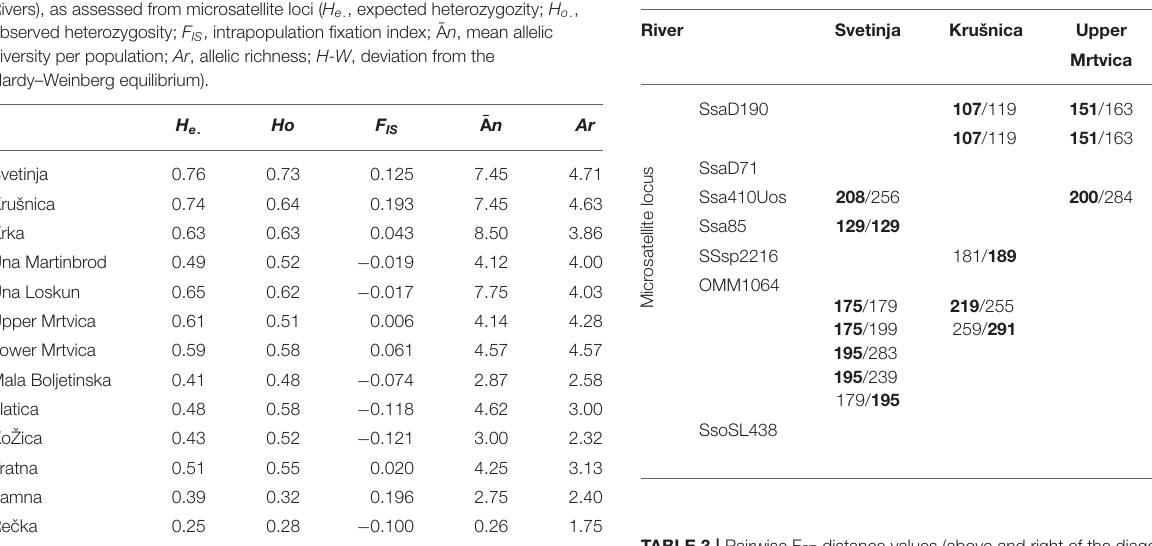
(B) SAMPLES FROM RIVERS IN THE IRON GATE GORGE